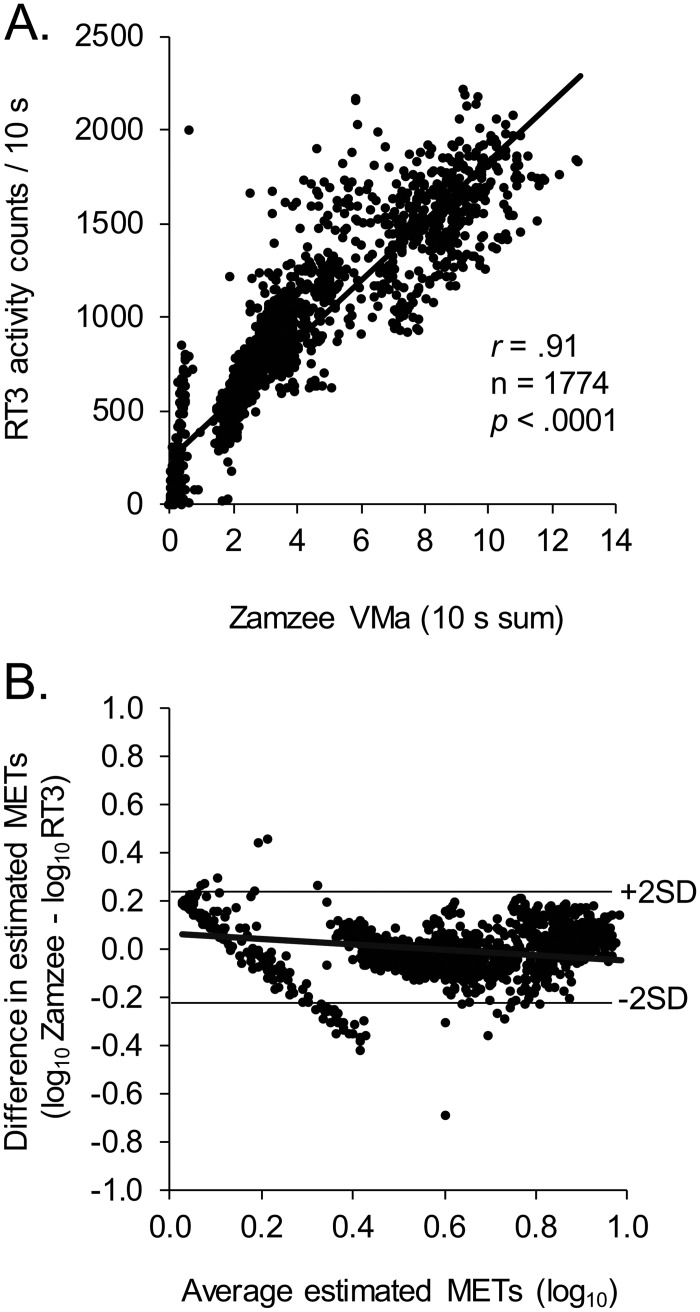
Correspondence between Zamzee and RT3 activity meters.Physical activity was experimentally varied by asking 31 middle school-aged adolescents (12–14 years of age) to sit at rest, perform standing stretches, walk slowly, walk normally, walk rapidly, shoot baskets, jog, play soccer, and sprint for .5–10 min intervals while wearing both RT3 and Zamzee activity monitors. (A) Zamzee activity measurement (3-d accelerometer vector magnitude; VMa) and RT3 activity counts were accumulated over 10 s intervals, and the magnitude of their monotonic relationship was assessed by Spearman r correlation coefficients. Solid line indicates linear regression function. Similar results emerged from analyzes of data that averaged over repeated measurements within individuals to form a single summary mean for each activity (n = 96, r = .97, p < .0001). (B) Bland-Altman plot of agreement between MET values estimated by Zamzee vs. RT3 (difference: log10 Zamzee—log10 RT3) as a function of MET intensity (average: [log10 Zamzee + log10 RT3] / 2). Solid line indicates linear regression function.